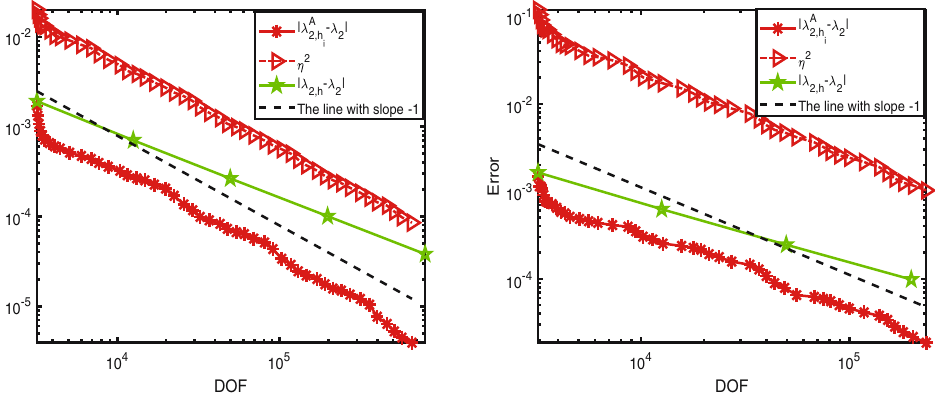
Figure 2: Error comparison of the second eigenvalue for ( 2.1 ) – ( 2.2 ) on the L - shaped domain ( the left: k = 1, n ( x ) = 4, the right: k = 1, n ( x ) = 4 + 4 i ) .